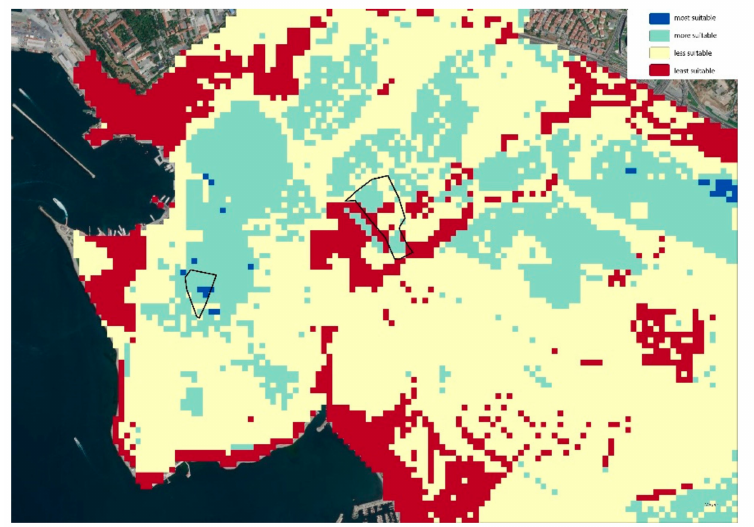
Figure A2. Kadikoy’s preselected and candidate areas to become